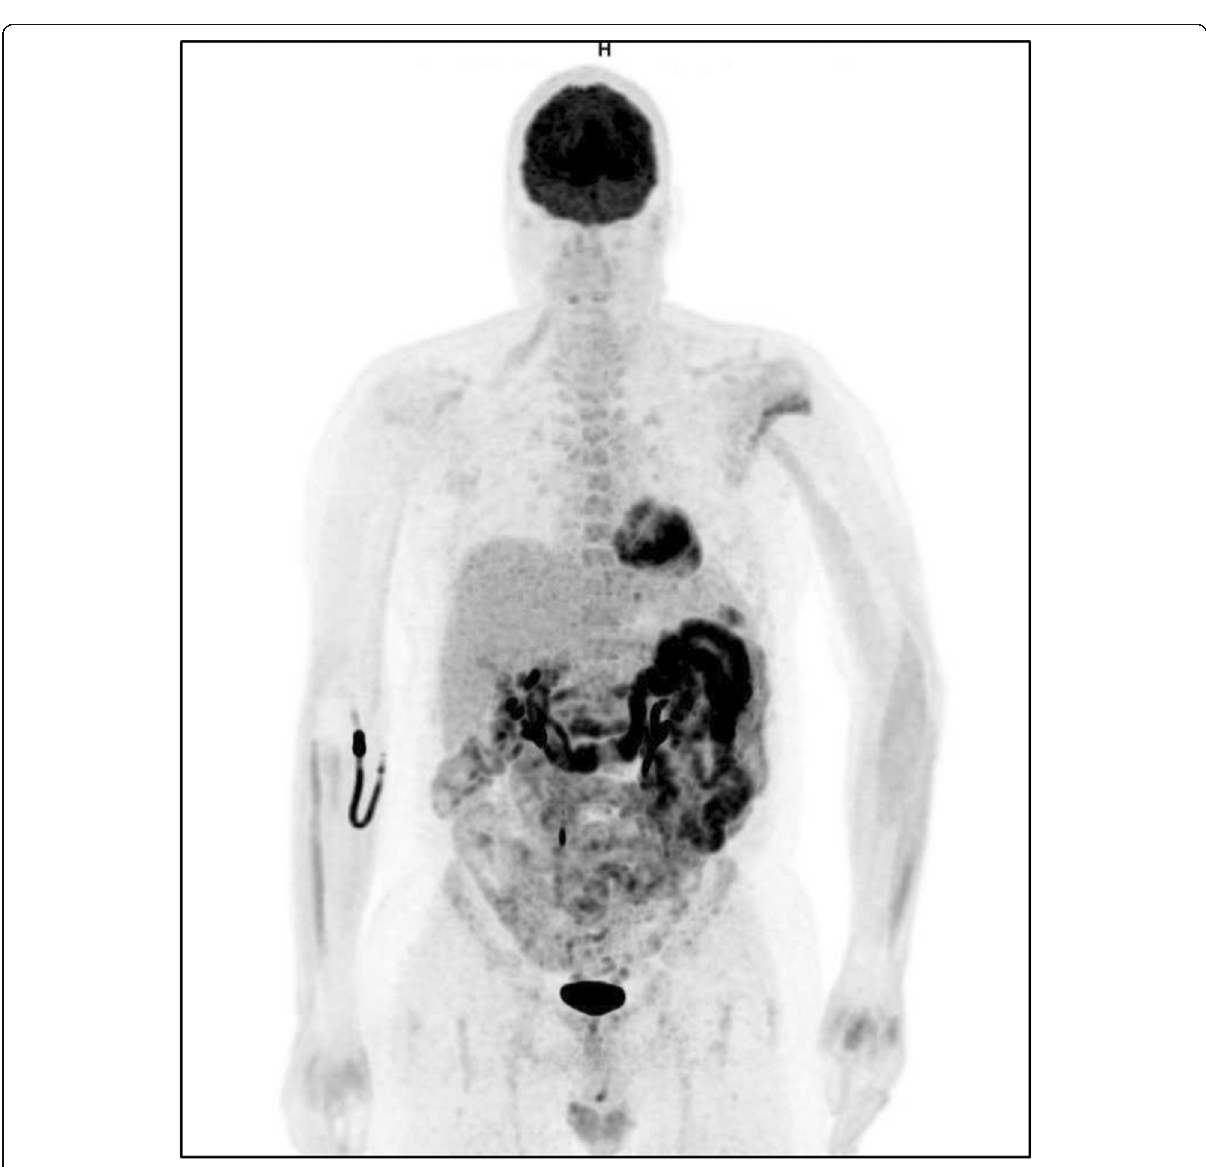
Fig. 5 18 F-FDG PET/CT image of a stage IV enterocolitis during anti-CTLA-4 treatment in a patient with metastatic melanoma. Immunotherapy was interrupted, and a high-dose steroid therapy was